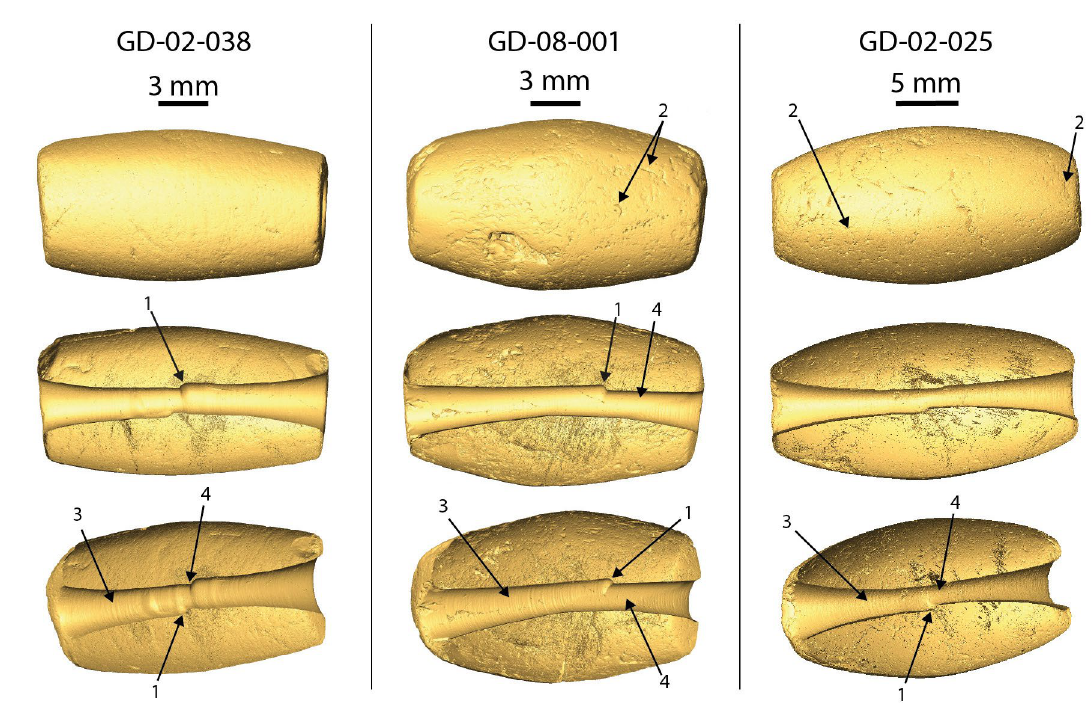
Figure 9: X-ray microtomography images of amethyst beads GD-02-038, GD-02-001, and GD-02-025. The tip of the perforations are “nipple” shaped with a rather flat terminal surface(1). Traces of surface staking are visible(2). Abrasive striations (3) and their absence in some parts (4) can be distinguished in the three perforations thanks to the high resolution reached for these 3D models.